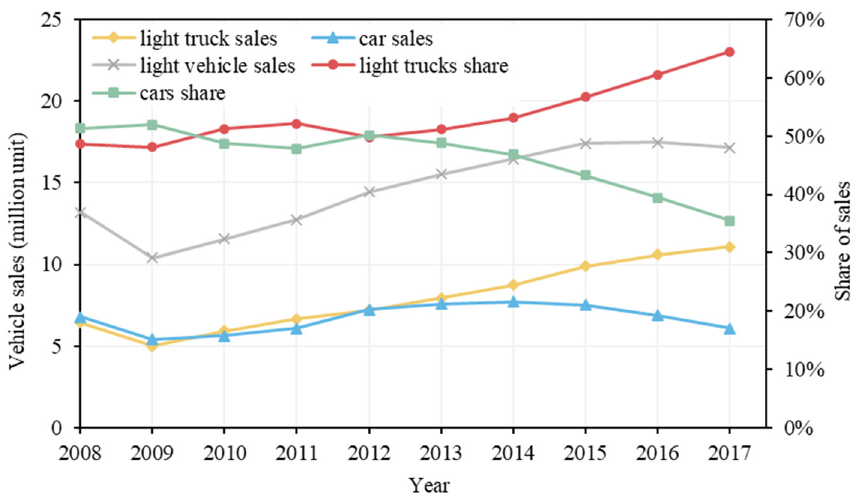
Figure 3. Vehicle sales in the U.S. from 2008 to 2017.